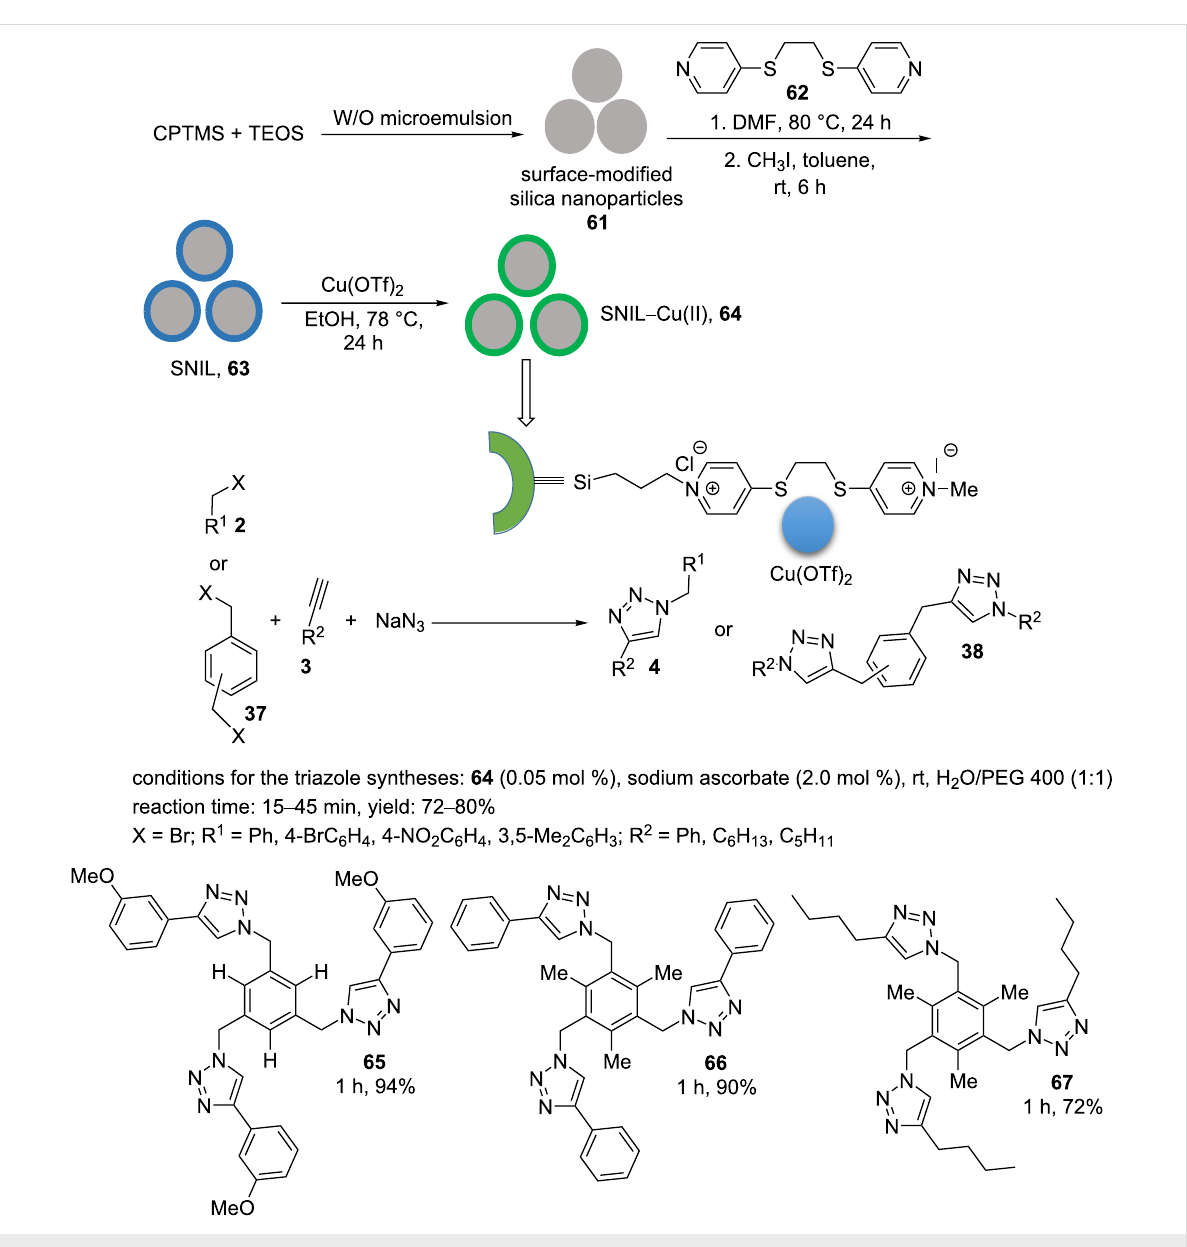
Scheme 10: Synthetic route to the catalyst 64 and catalytic application of 64 in “click”